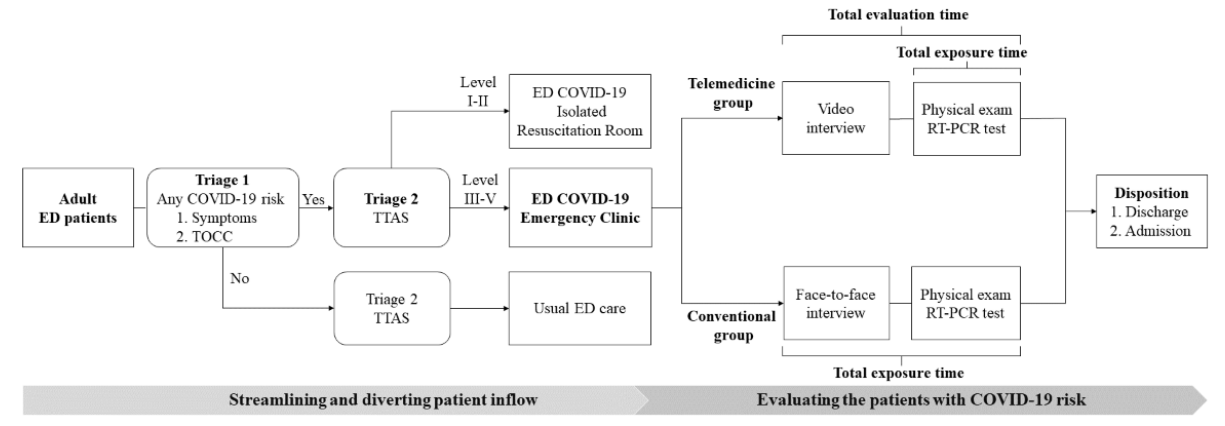
Figure 1. Diagram of the double triage and telemedicine protocol. COVID-19: coronavirus disease; ED: emergency department; TOCC: travel, occupation, contact, and cluster history; TTAS: Taiwan Triage and Acuity